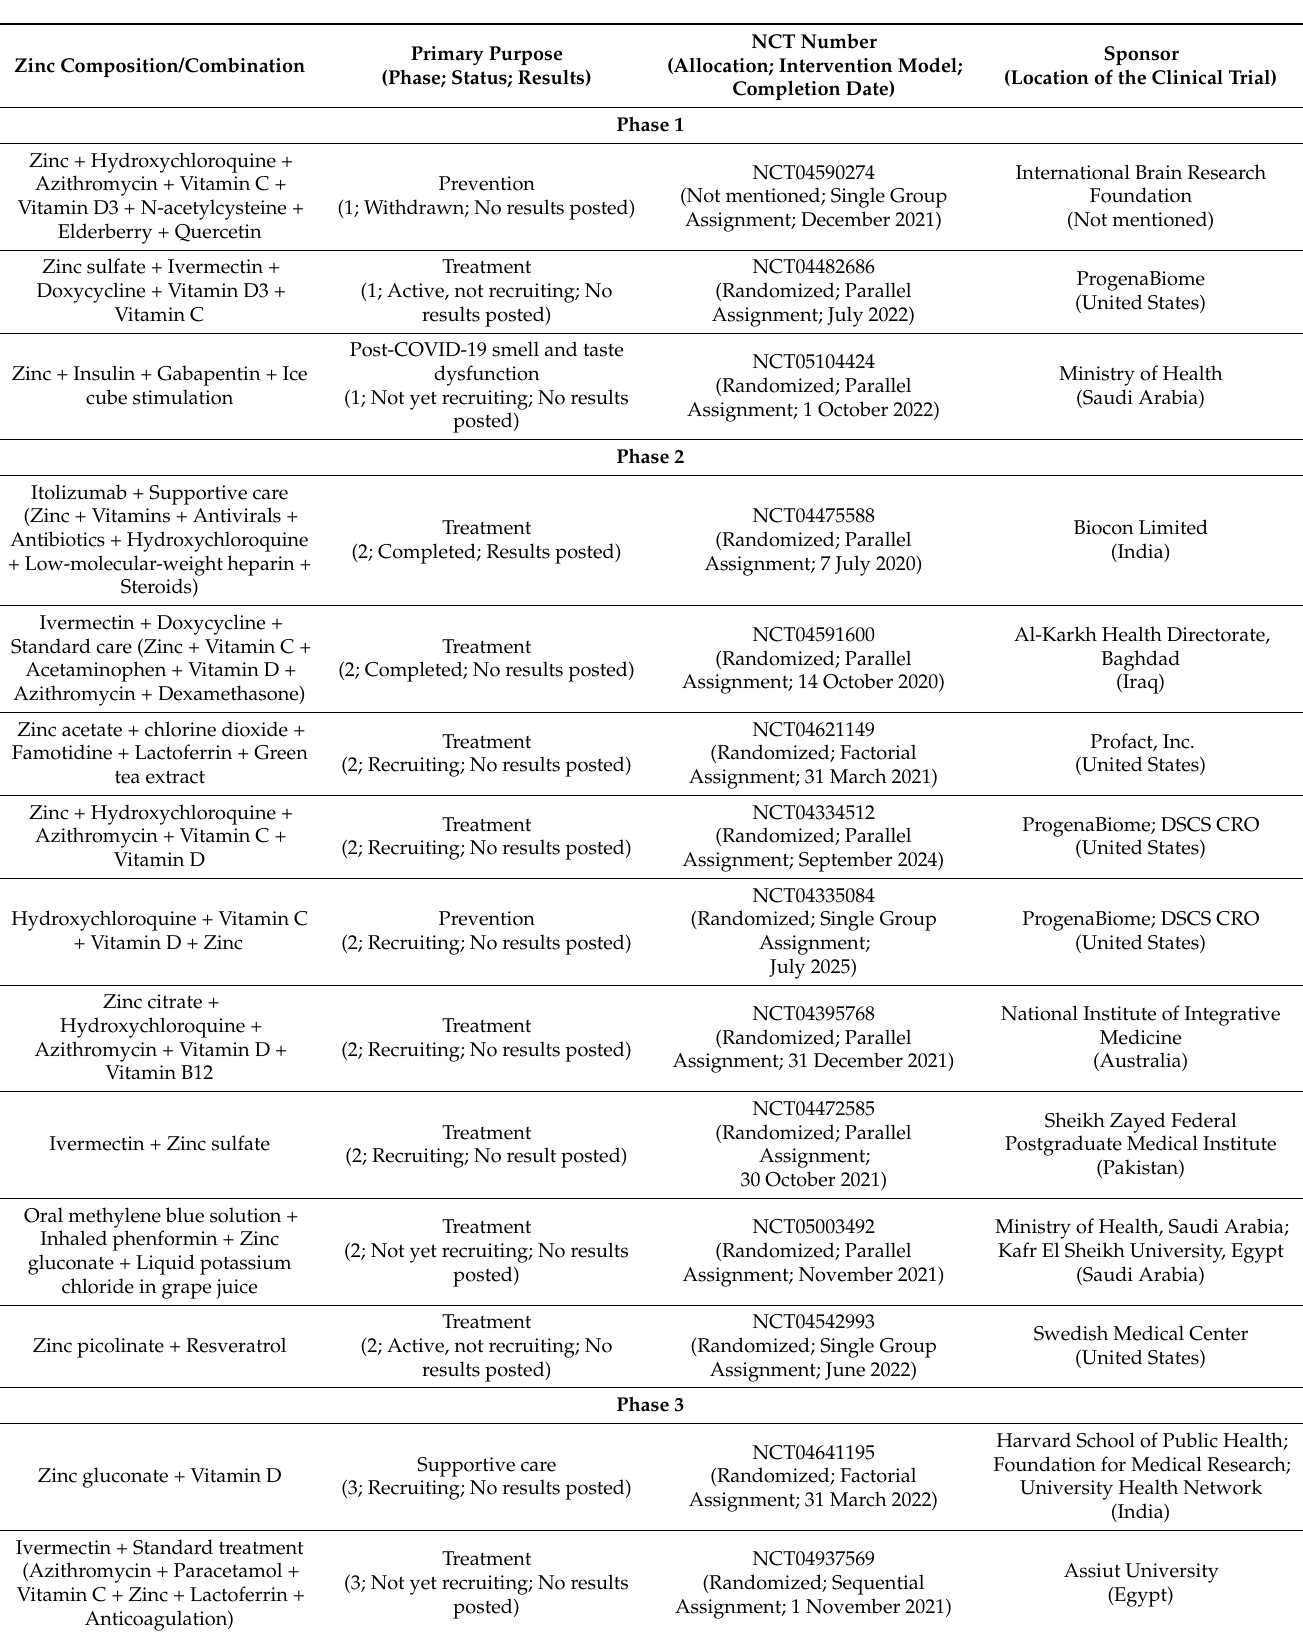
Table 3. Interventional clinical studies on zinc compositions for the treatment of